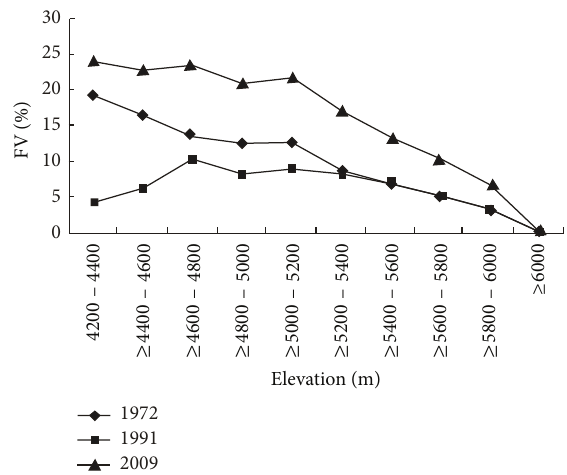
Figure 7: The increased fractional vegetation cover along